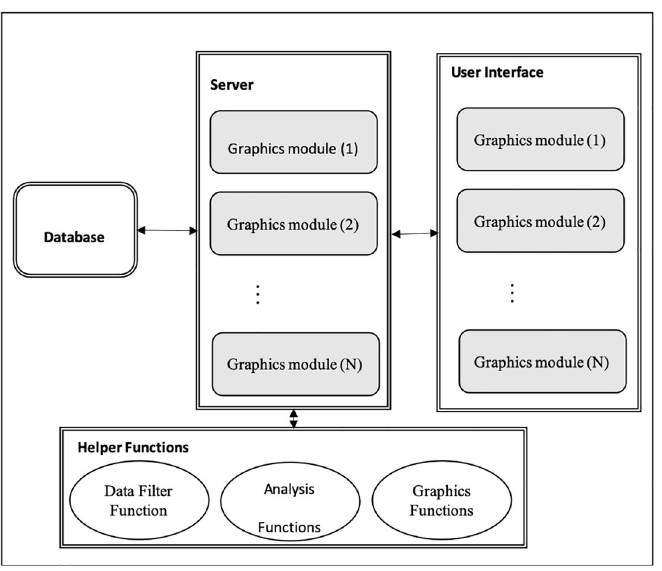
Fig 1. Diagram illustrating the organization of the app. The app uses a modular design with separate server and user interface (UI) functions for each interactive graphics module. Graphics modules call non-reactive helper functions to filter data, analyze data, and generate graphics. Separate modules are used to handle downloading plots and data summaries (not